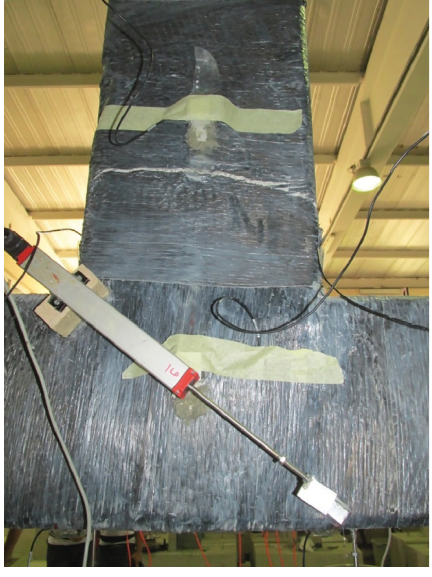
Figure 14: Failure of Sample 4 (flexural failure cannot be seen because of CFRP